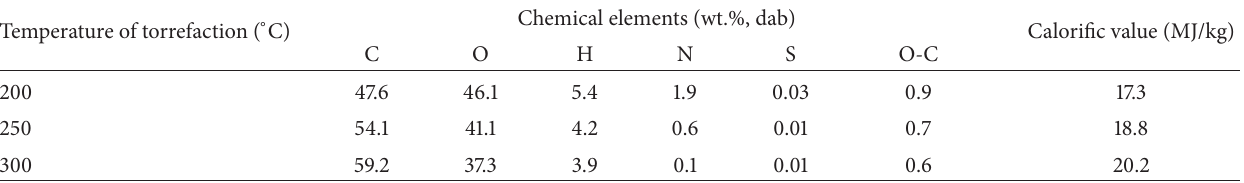
Table 3: Ultimate and calorific value analyses of bagasse at different torrefaction temperatures. Temperature of torrefaction ( ∘